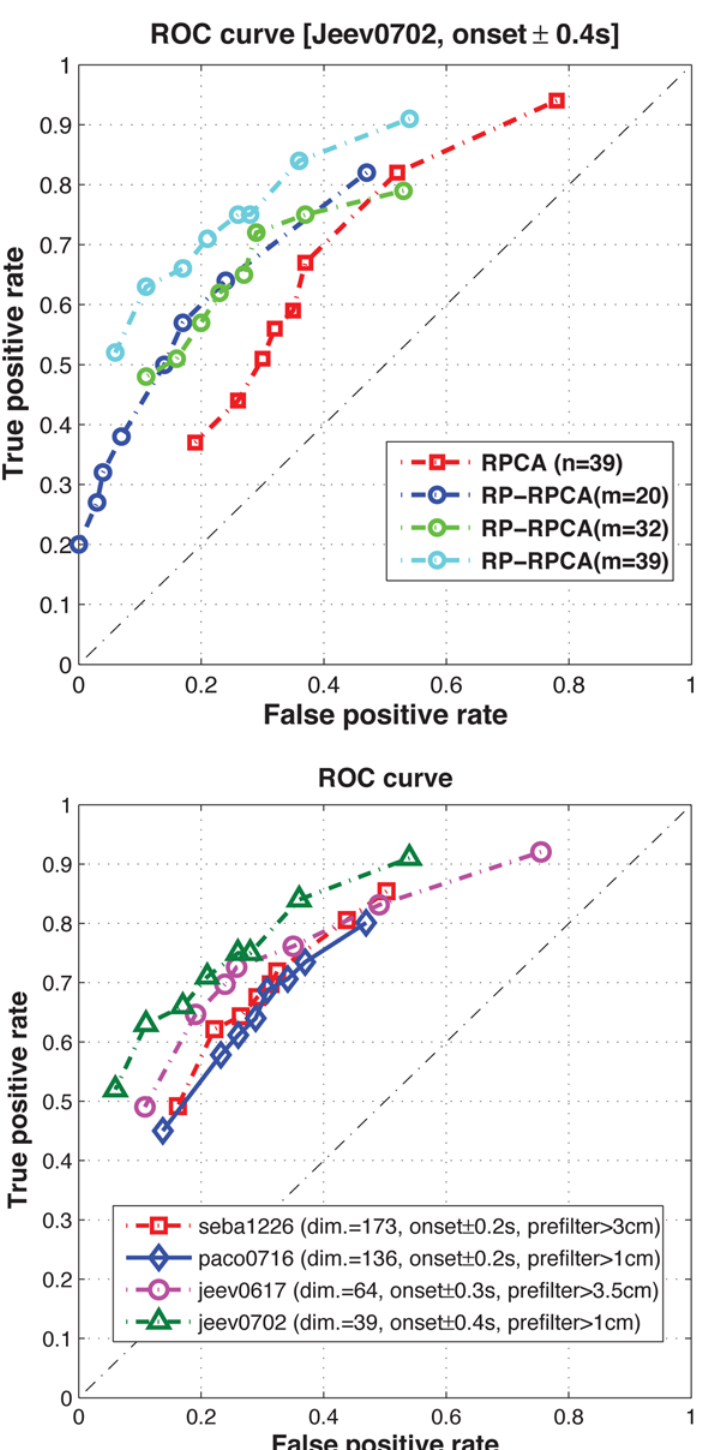
Fig 5. Receiver Operating Characteristic (ROC) curve of the prediction of submovement onset. (a) comparison between RPCA and RP-RPCA (target jumps task) (b) different monkeys or tasks where we prefiltered certain submovements with small amplitude in order to avoid artifacts of